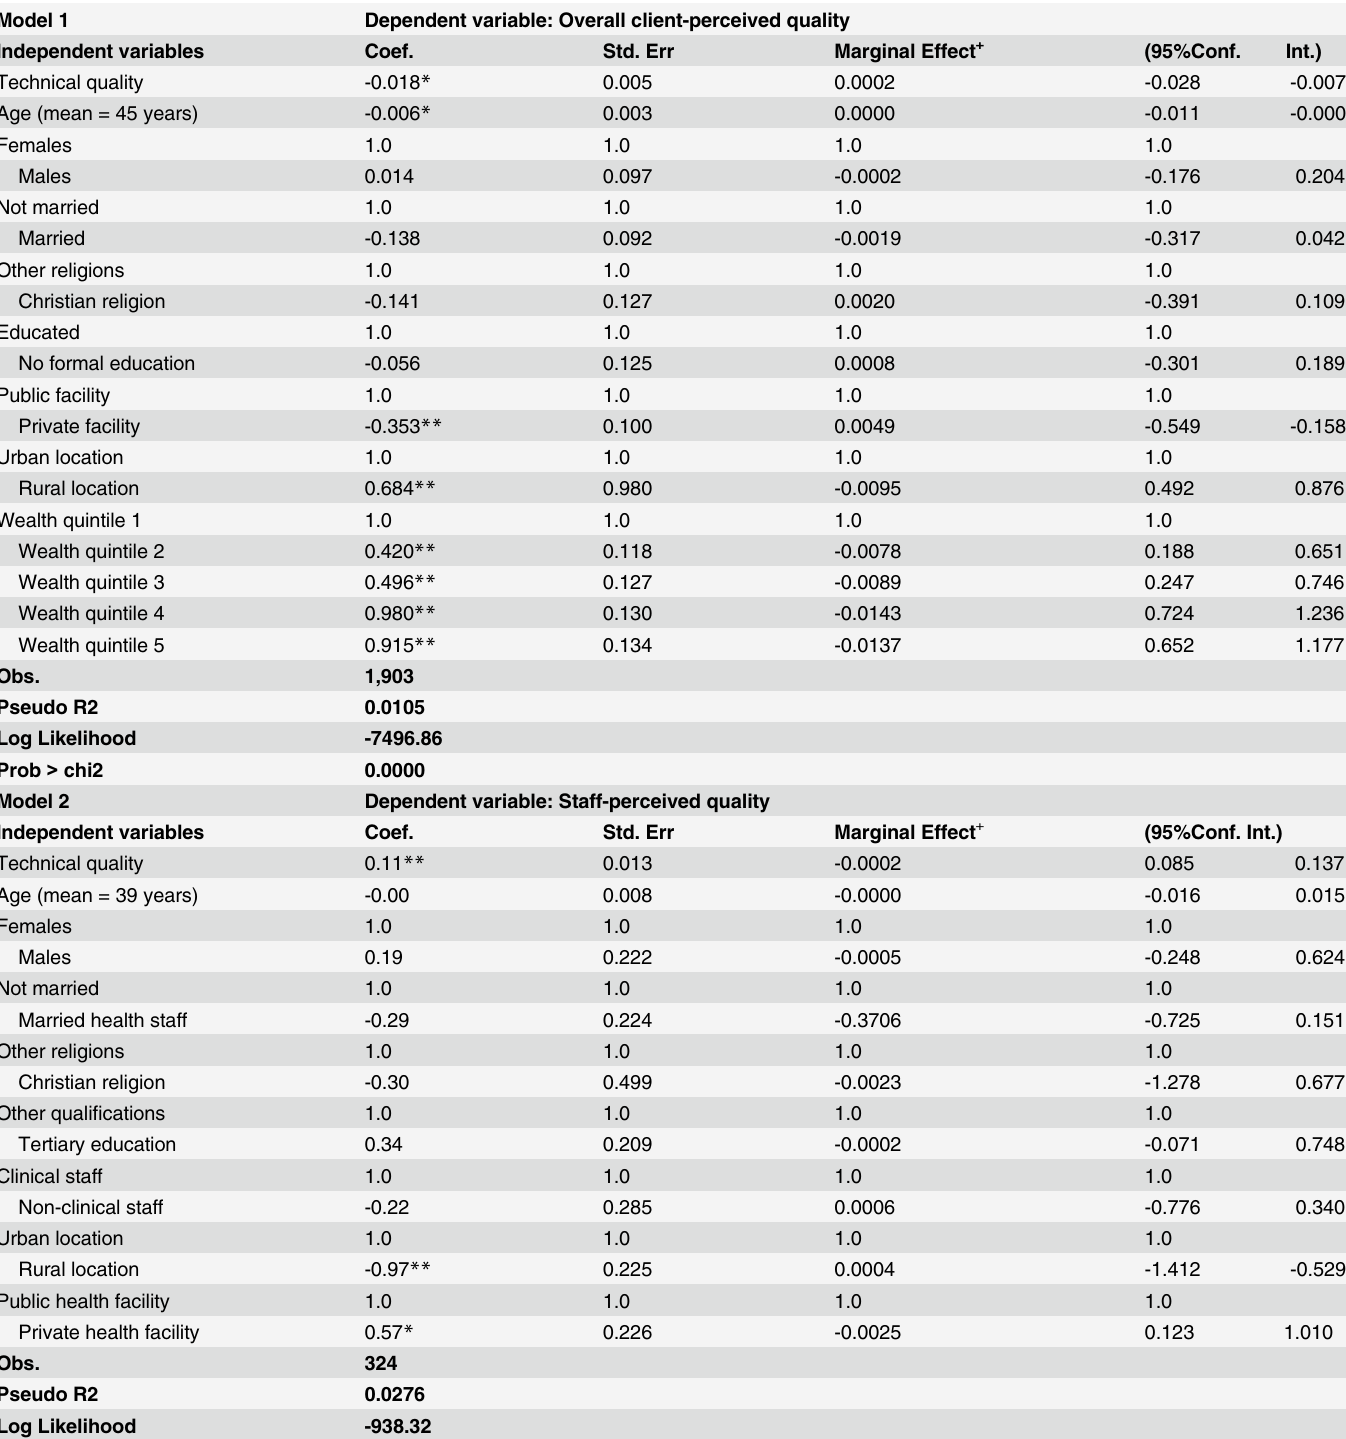
Table 5. Bivariate analysis of predictors of client and staff perceived quality care with marginal